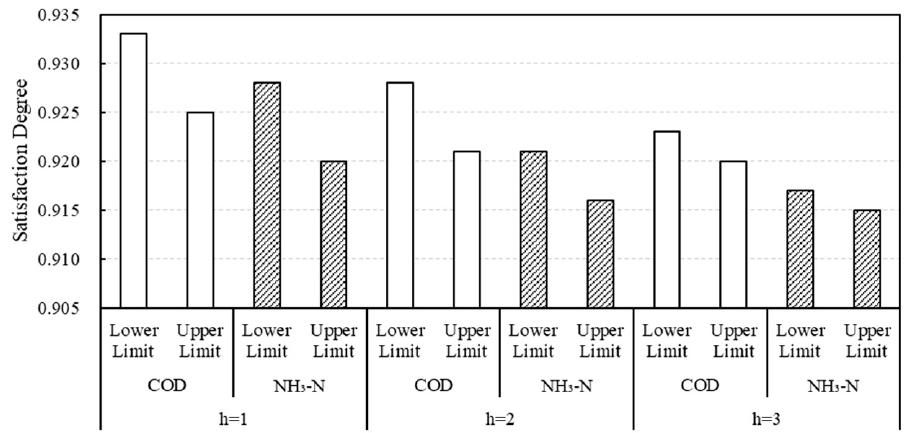
Figure 4. Satisfaction degree of the emission rights allocation scheme under different scenarios.